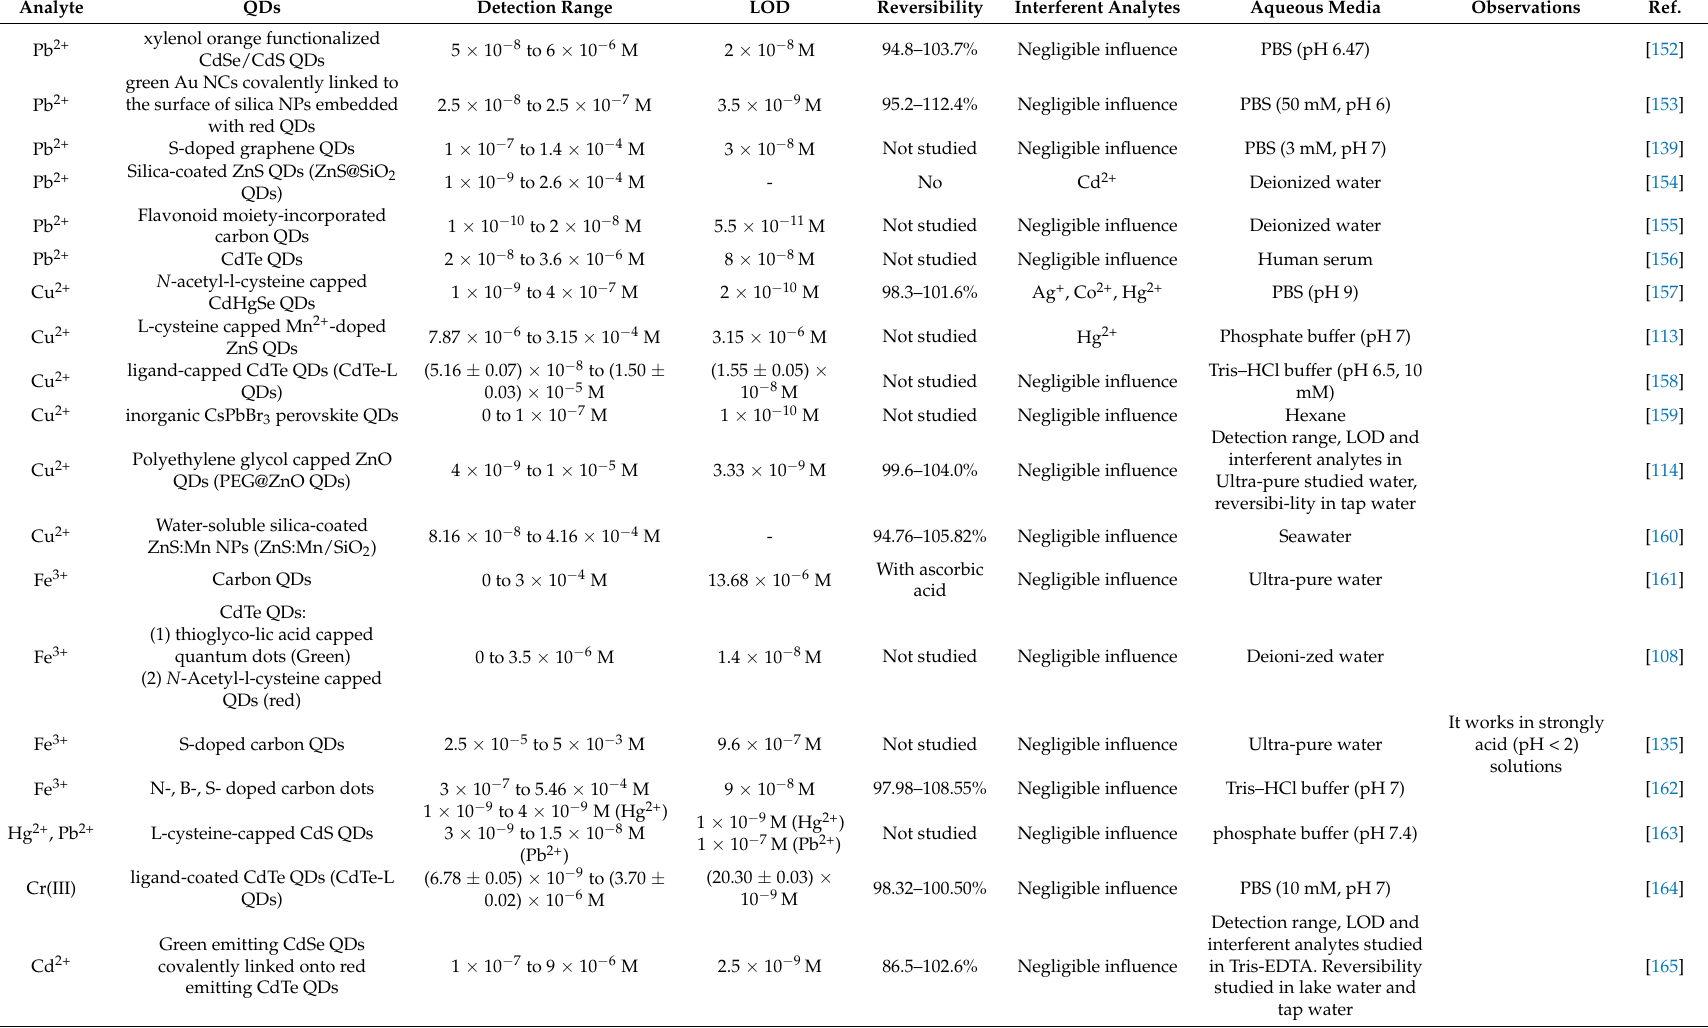
Table 4. Fluorescent sensors for different metal ions based on